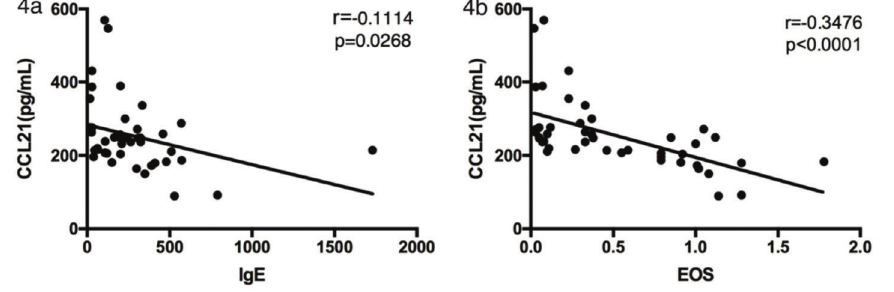
Figure 4 - Correlation between serum CCL21 and IgE levels and eosinophil counts in patients with asthma. The correlation analysis was performed to analyze the relationship between CCL21 levels and (a) serum IgE levels and (b) eosinophil counts. CCL, chemokine ligand.